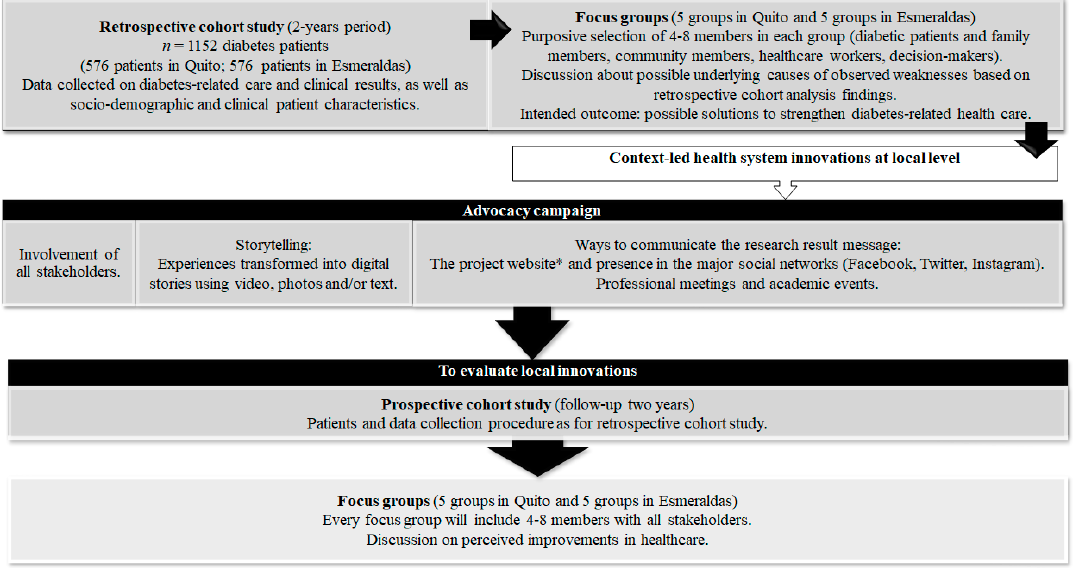
Figure 1. Study design and description of the phases that constitute it. * The project website is https://www.ceadproject.eu/ accessed on 15 January 2021.